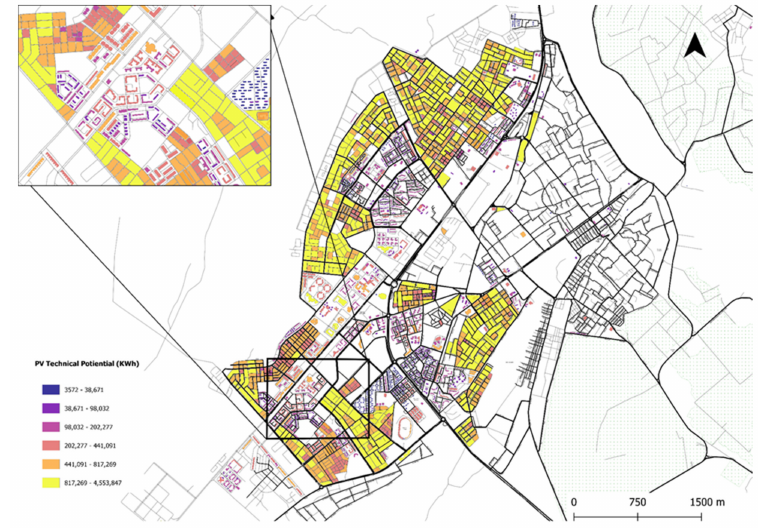
Figure 10. Technical PV potential in Laghouat